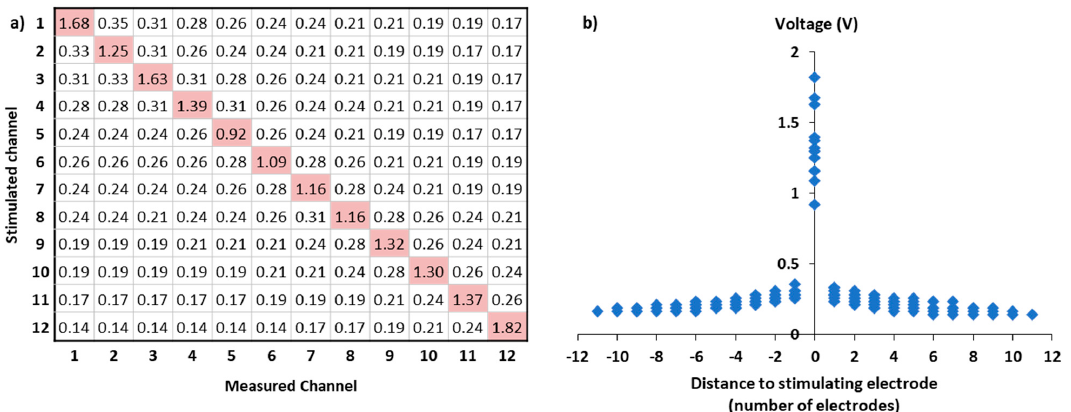
Figure 2. Example of the voltage matrix, in V ( a ) of one subject (S35) collected during impedance field telemetry measurement with the MAESTRO software (MED-EL GmbH, Innsbruck, Austria). Measurement of electrodes’ impedance consists in activating one electrode at a time and then measuring the voltage detected by every electrode of the cochlear implant array. The resulting voltages are plotted as a function of the distance between the stimulating and the recording electrode expressed in number of electrodes ( b ).